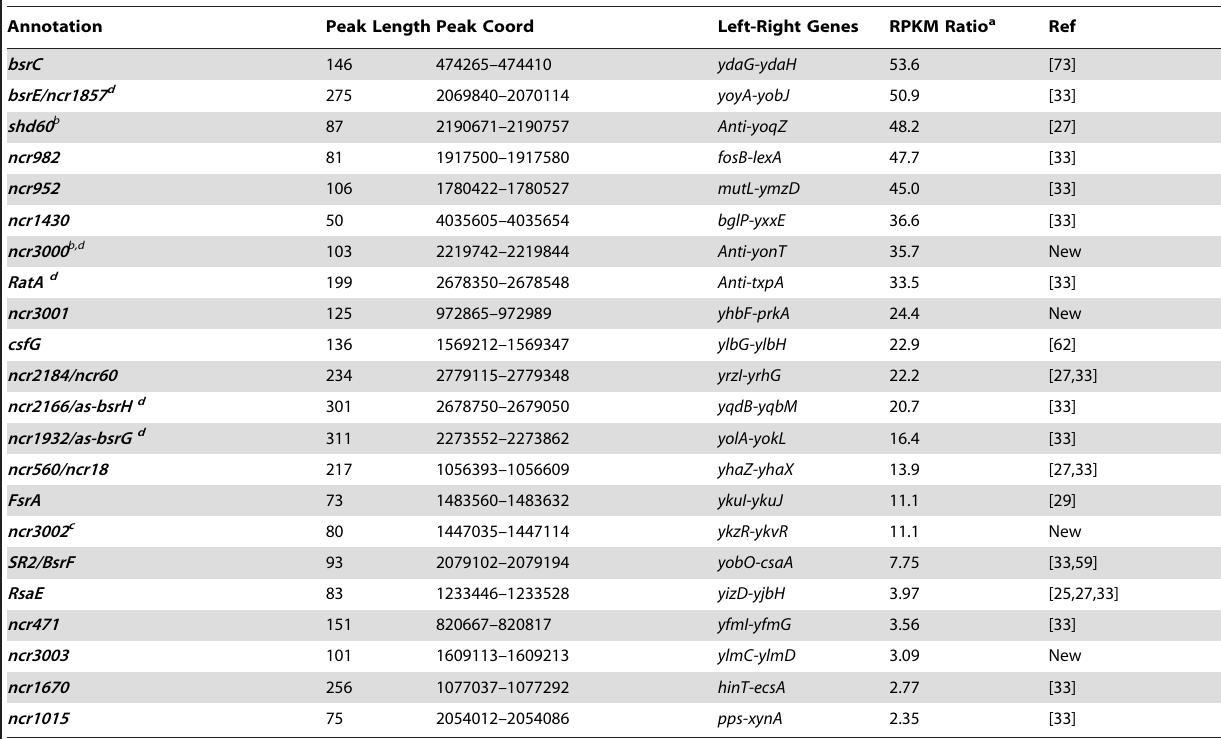
Table 1. Putative sRNAs that coIP with Hfq.